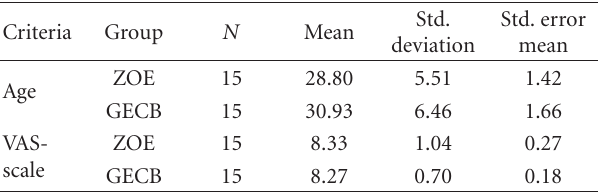
Table 1: Comparison of age and VAS-scale of the patients between the groups.